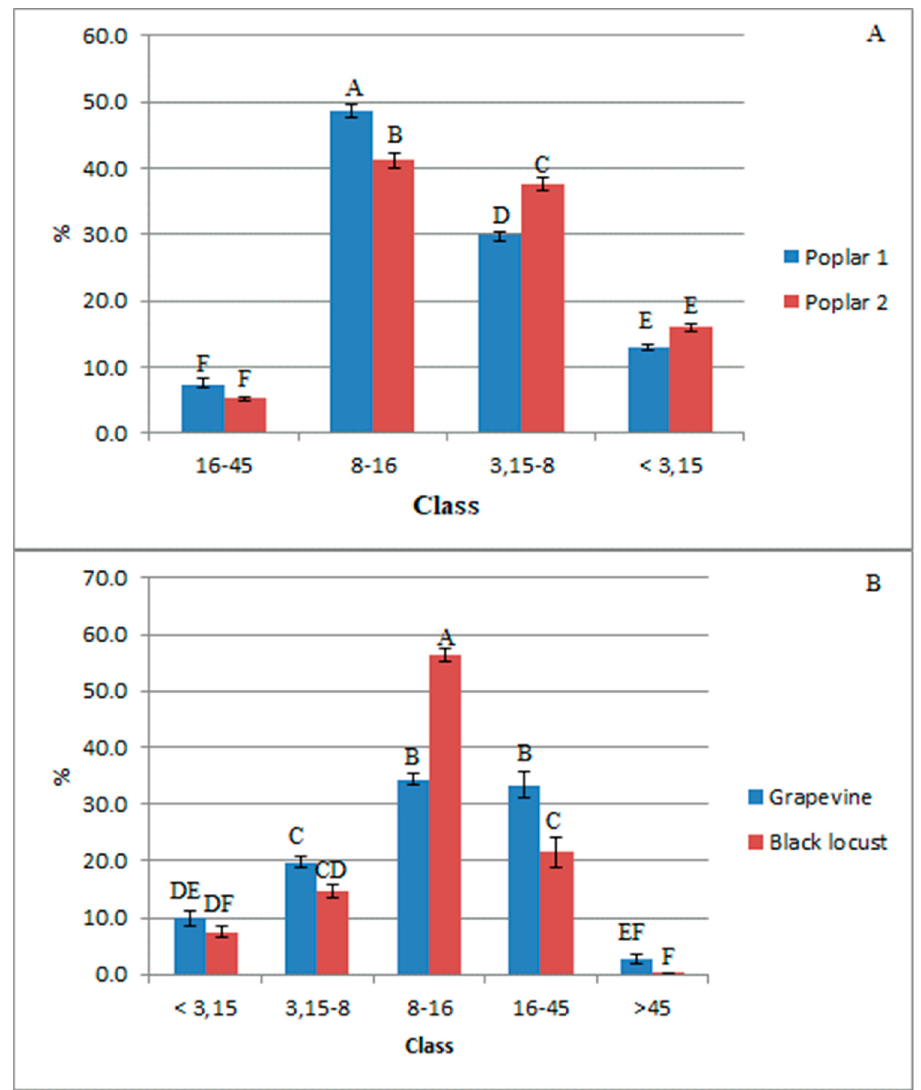
Figure 5. Particle size distribution (mean ± SE) of the wood chips: ( A ) Poplar 1 and Poplar 2; ( B ) grapevine and black locust. Within each size class, different letters indicate a significant difference at the level of P ≤ 0.01 after Tuckey’s HSD test. Before the ANOVA analysis the data were transformed as square root of the arcsine.